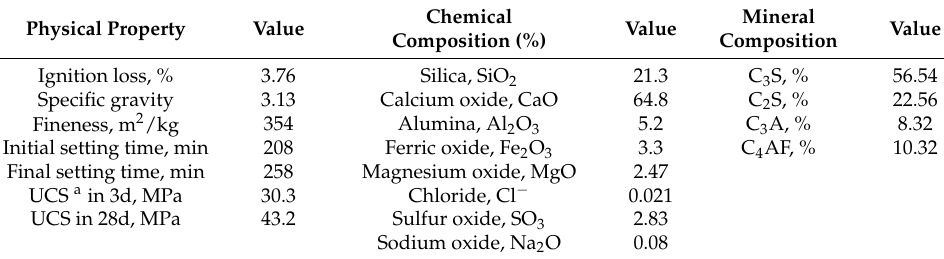
Table 2. Properties of cement utilized for this experiment.